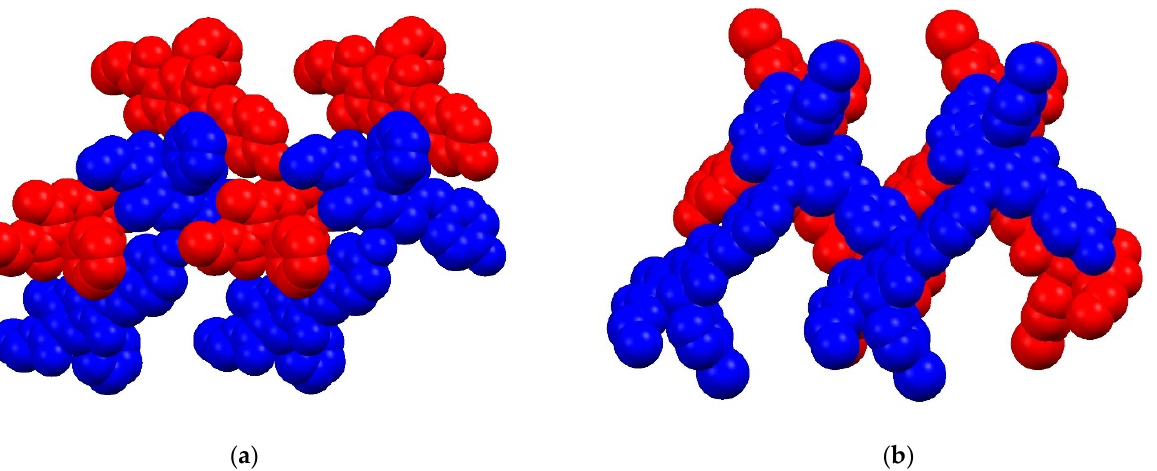
Figure 8. A portion of crystal packing of R- and S-homochiral chains (colored in blue and red, respectively) for 13 ( a ) and 14 ( b ).